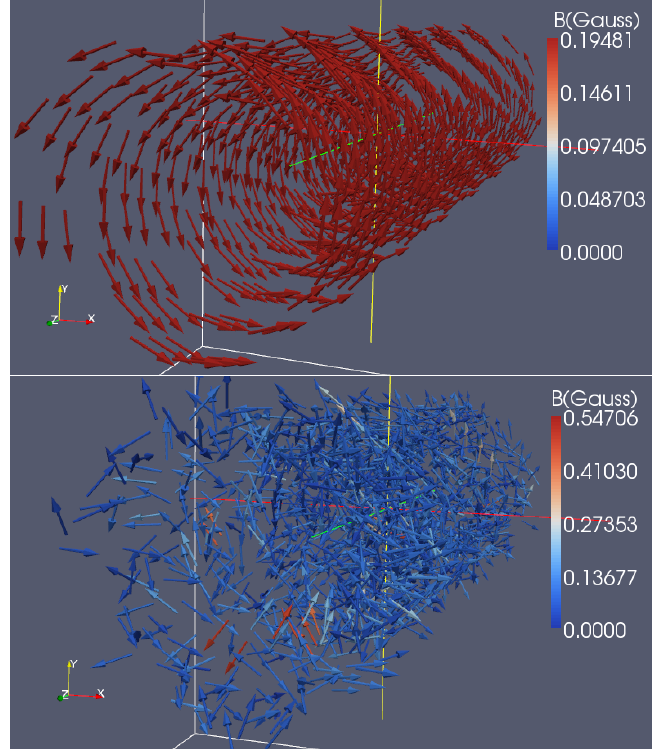
Figure 2. ( Upper panel ) A 3D visualization of the ordered helical magnetic field within the first TEMZ simulation. Each vector highlights the magnetic field strength within an individual plasma cell (see color bar to the right for field strength in Gauss). ( Lower panel ) A 3D visualization of the disordered magnetic field within the second TEMZ simulation. The field here is partially re-ordered after crossing the conical